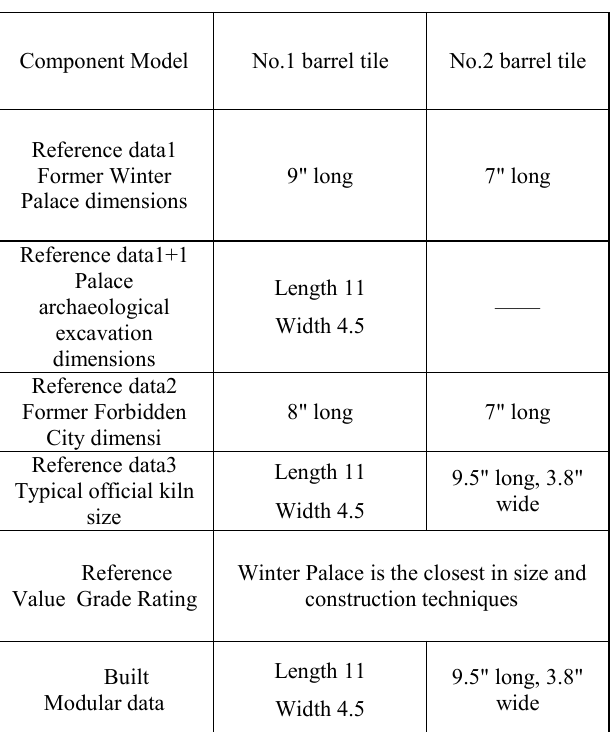
Table 1 . Modulo analysis table